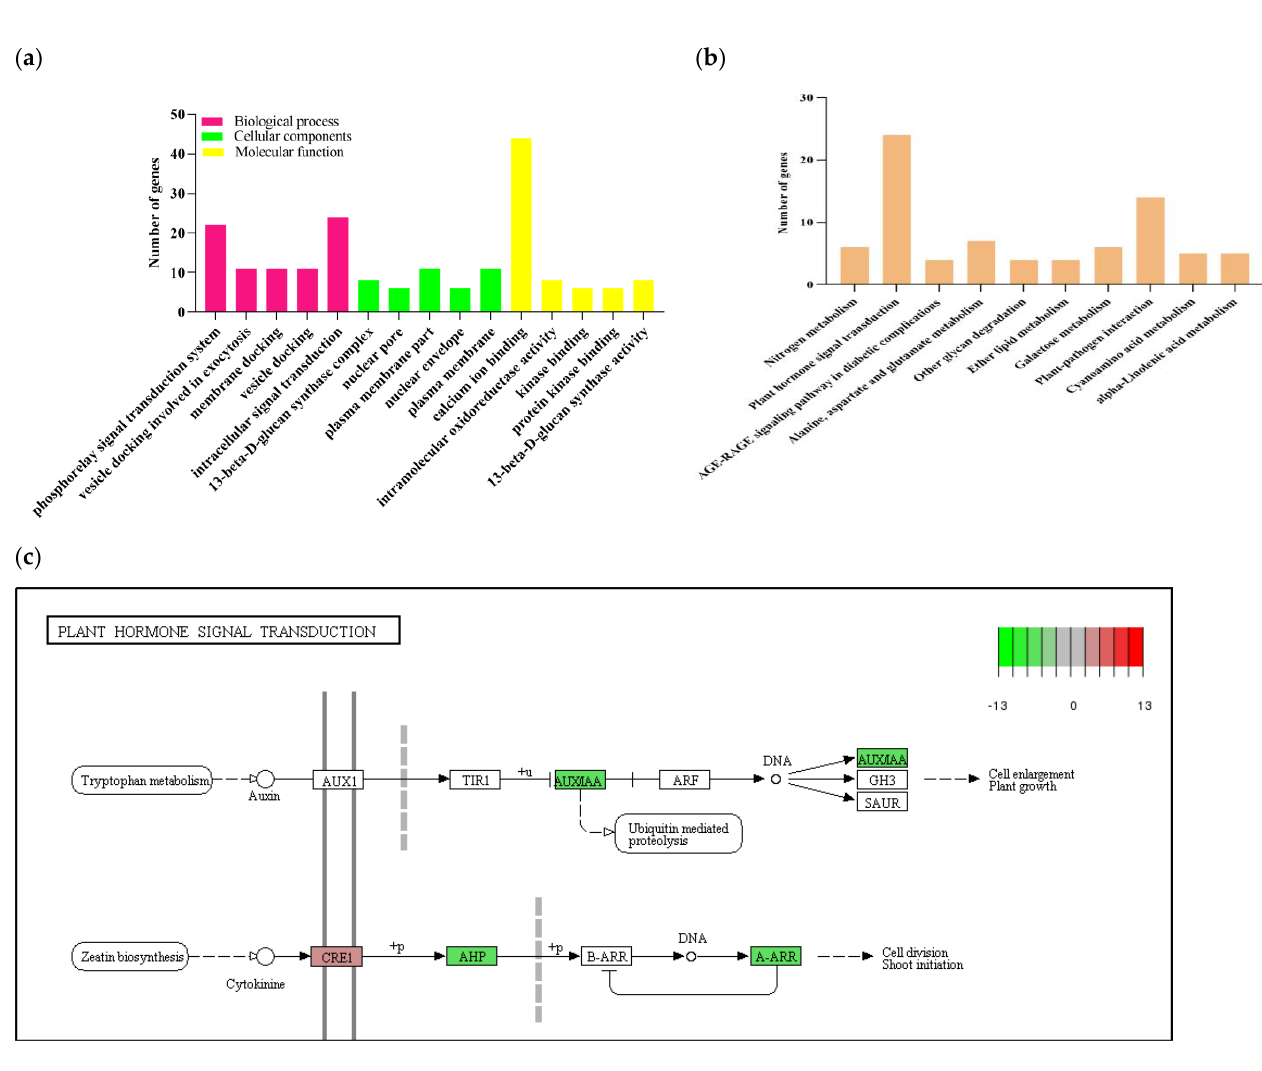
Figure 5. Functional analysis of the differentially expressed genes (DEGs) between the BnKAT2 - overexpressing and wild-type B. napus plants. ( a ) GO enrichment of DEGs. ( b ) KEGG enrichment of DEGs. ( c ) Phytohormone signaling pathways associated with the genes downregulated (green) and upregulated (red) in the BnKAT2 -overexpressing plants.